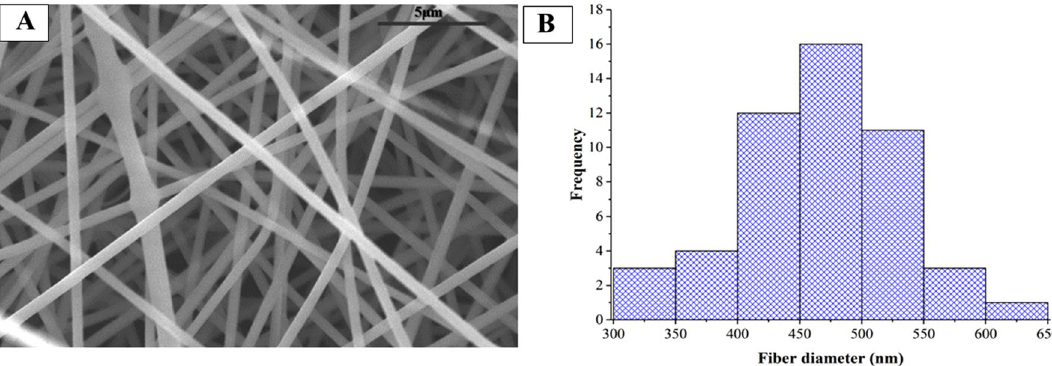
Figure 2. SEM image of the electrospun sample prepared from PVP-based precursor solutions containing medium-sized Extracellular Vesicles (mEV) (magnification: 2500×) ( A ) and fiber diameter distribution of sample ( B ).